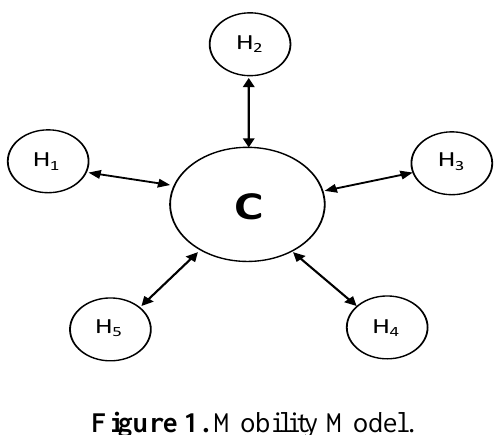
Figure 1. Mobility Model.